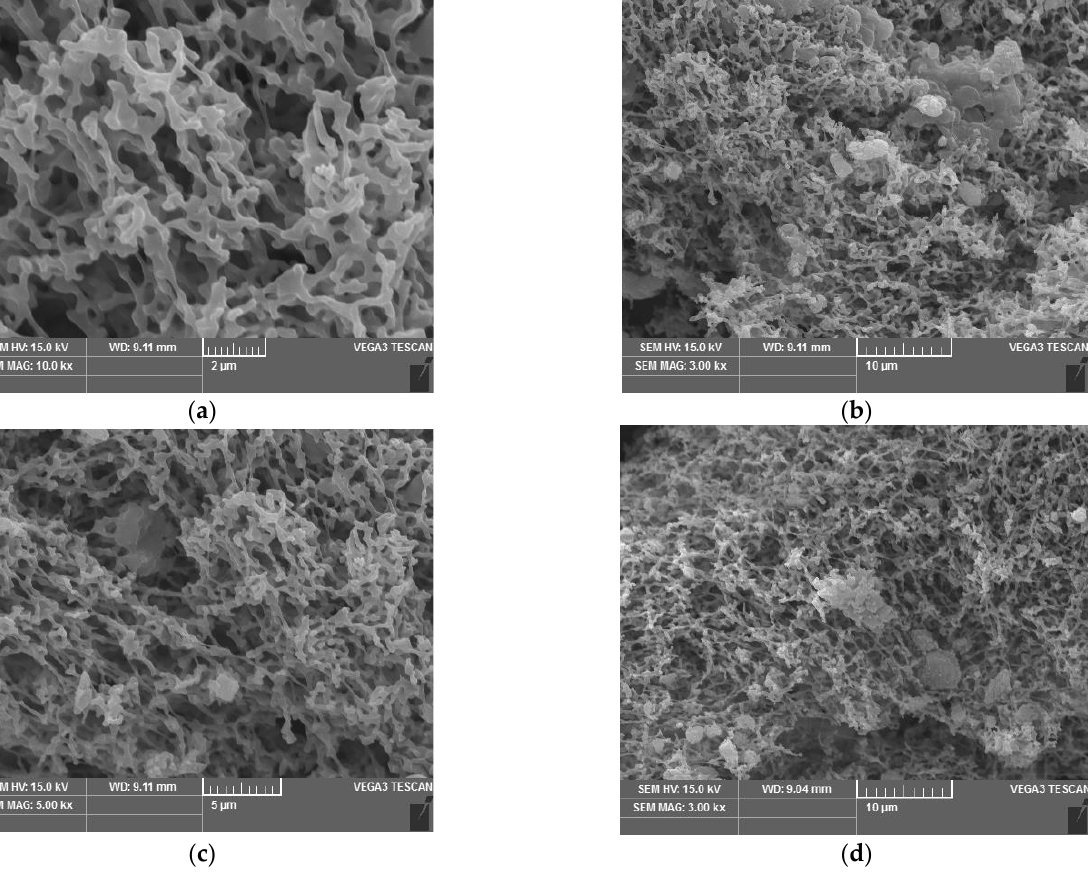
Figure 2. The SEM images of Microcystis aeruginosa before and after adsorbing copper, cadmium and nickel ions. ( a ) Algae powder; ( b ) Adsorption of Cu 2+ by algae powder; ( c ) Adsorption of Cd 2+ by algae powder; ( d ) Adsorption of Ni 2+ by algae powder.